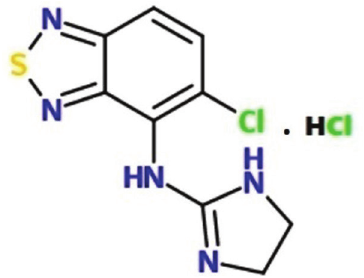
FIGURE 1 - Chemical structure of tizanidine HCl (MW = 290.17 Da, pKa = 7.4, Log p = 2.02, t